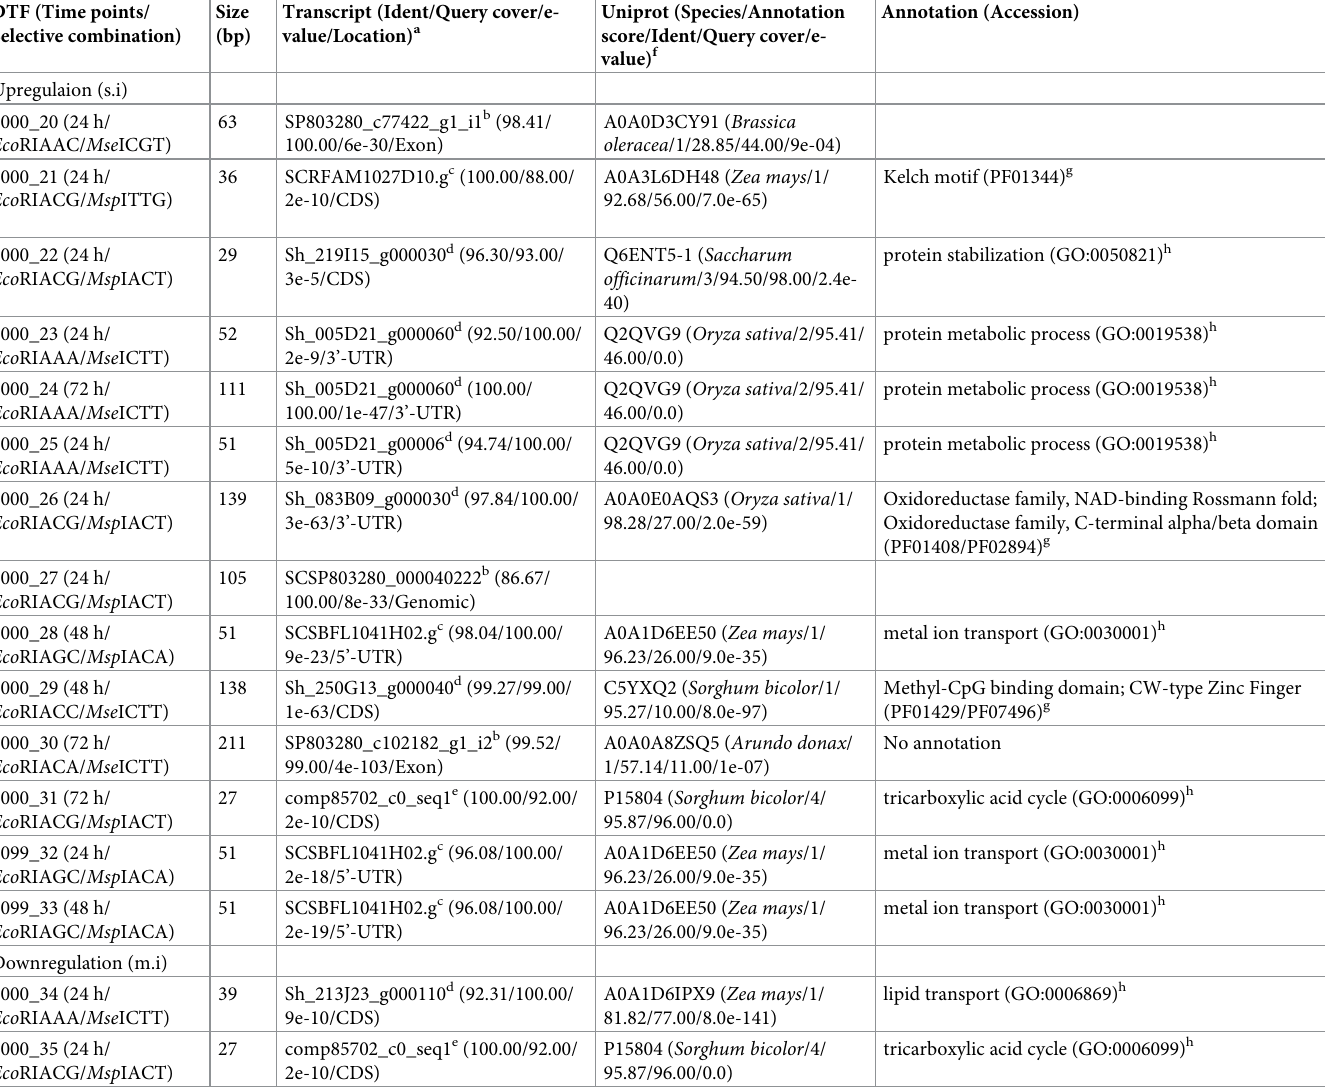
Table 4. BLASTN analysis of 16 differentially transcribed fragments (DTFs) and BLASTX analysis of the respective sugarcane transcripts. DTF (Time points/ Selective